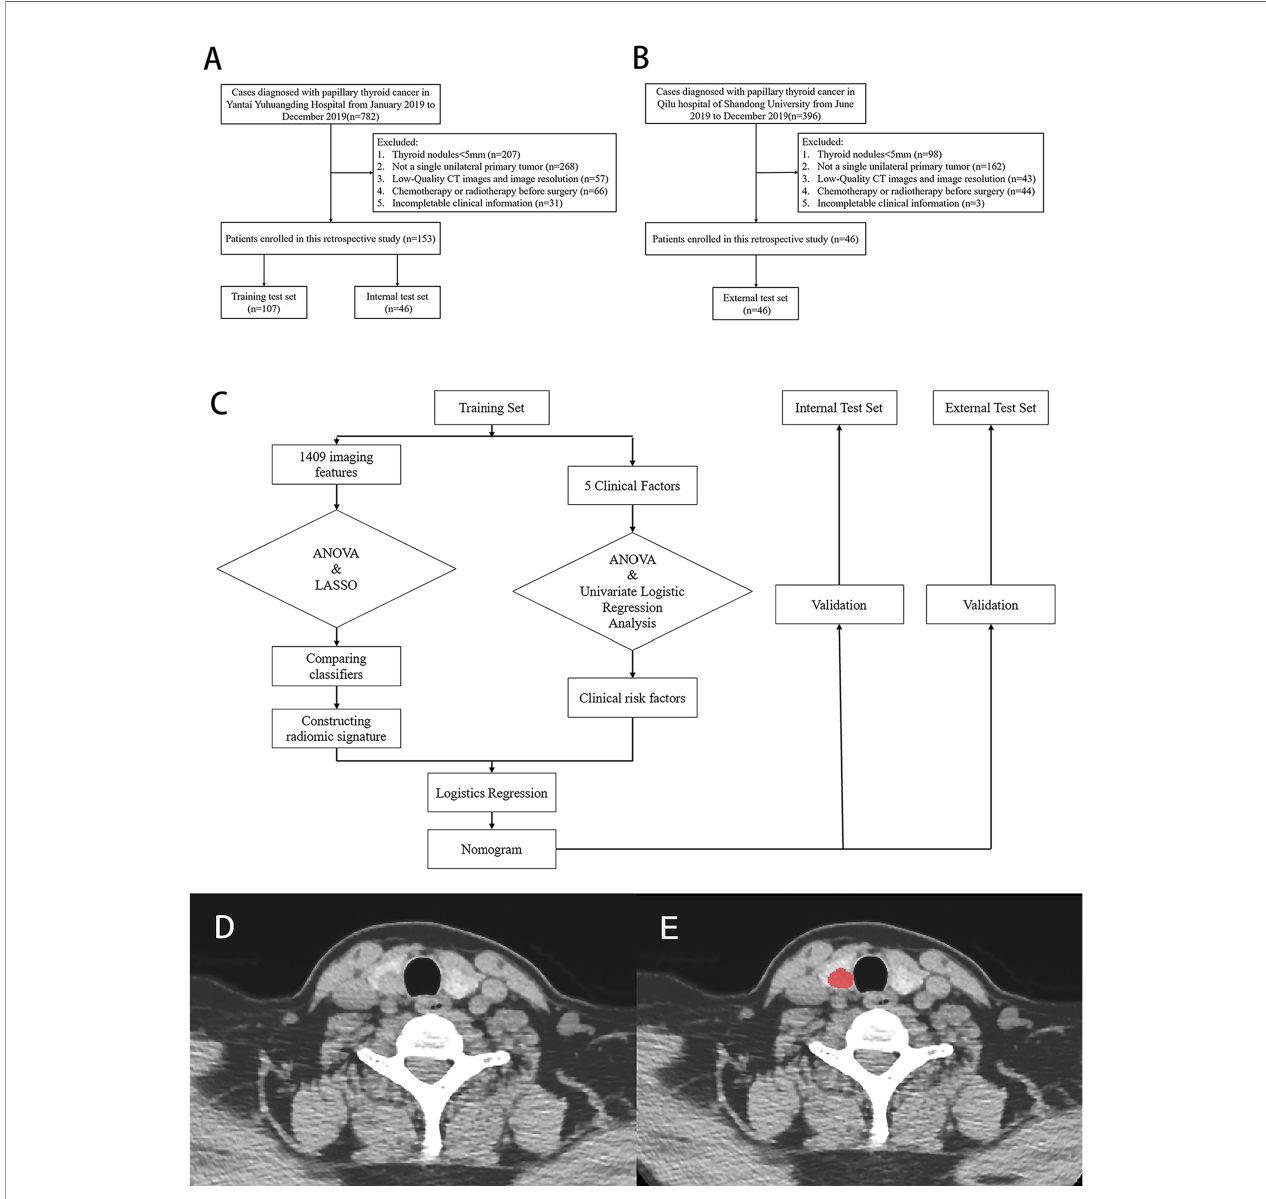
FIGURE 1 | Flow chart of patients ’ enrolment in (A) training, internal test set and (B) external test set. (C) Flow chart of study work. (D, E) Examples of regions of interest (ROIs) segmentation on contrast-enhanced computed tomography (CE-CT)